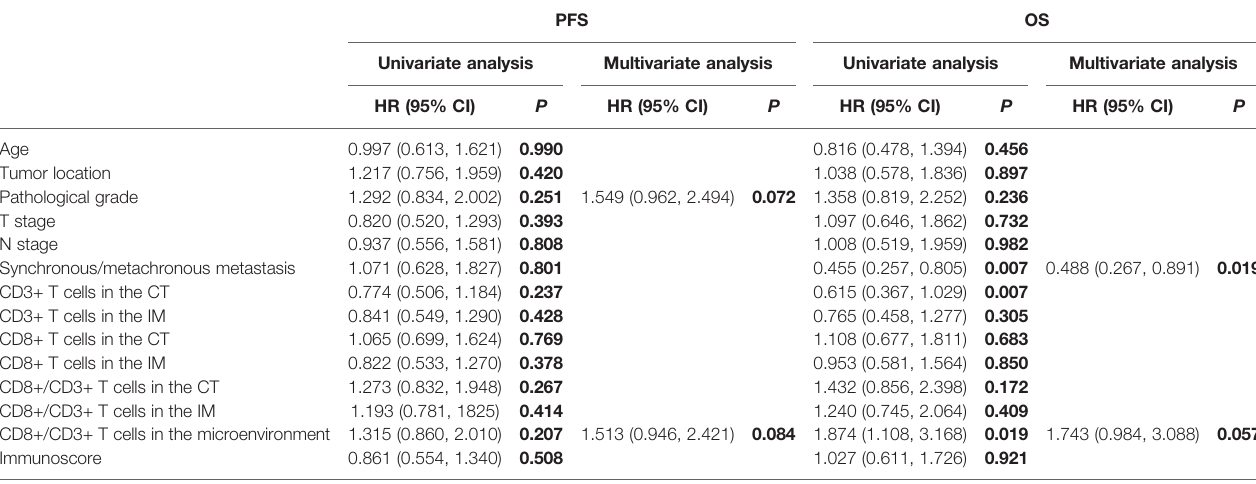
TABLE 3 | Univariate and multivariate analyses of the in fl uence of immune cell in fi ltration and clinicopathological factors on survival in all enrolled patients of 108. PFS OS Univariate analysis Multivariate analysis Univariate analysis Multivariate analysis